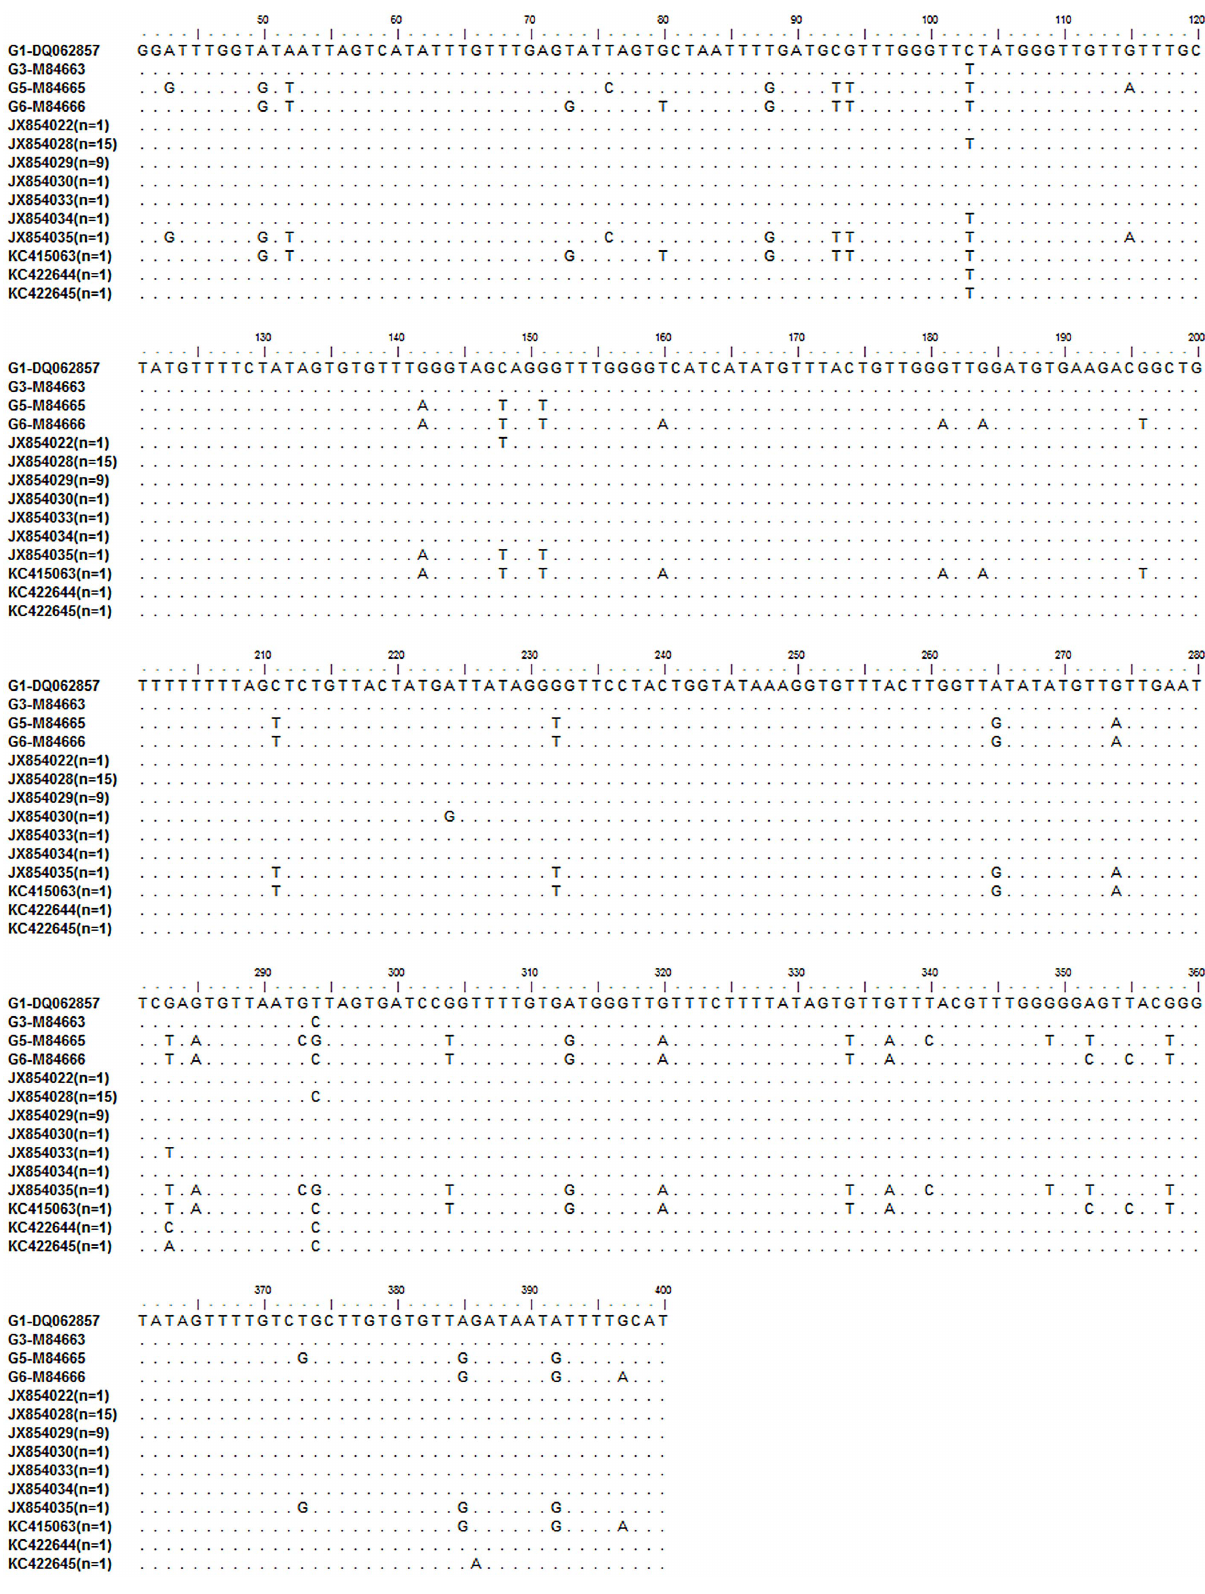
Figure 2. Multiple alignments of partial cox1 gene sequences. Accession numbers with suffix JX and KC are the representative sequences of G1, G3, G5 and G6 genotypes and their haplotypes found in this study. Accession numbers DQ062857, M84663, M84665 and M84666 are the respective references sequences of G1, G3, G5 and G6 genotypes of E. granulosus retrieved from GenBank for comparison. n indicates the number of isolates detected for each haplotype. doi:10.1371/journal.pntd.0002262.g002 PLOS Neglected Tropical Diseases | www.plosntds.org